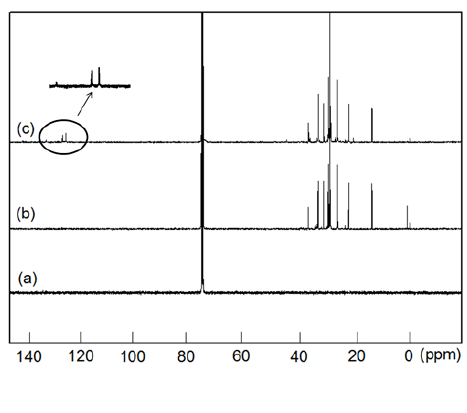
Figure 4. 13 C-NMR spectra of ( a ) PE; ( b ) poly(ethylene-co-1-decene) (PED) and ( c ) PEDM.